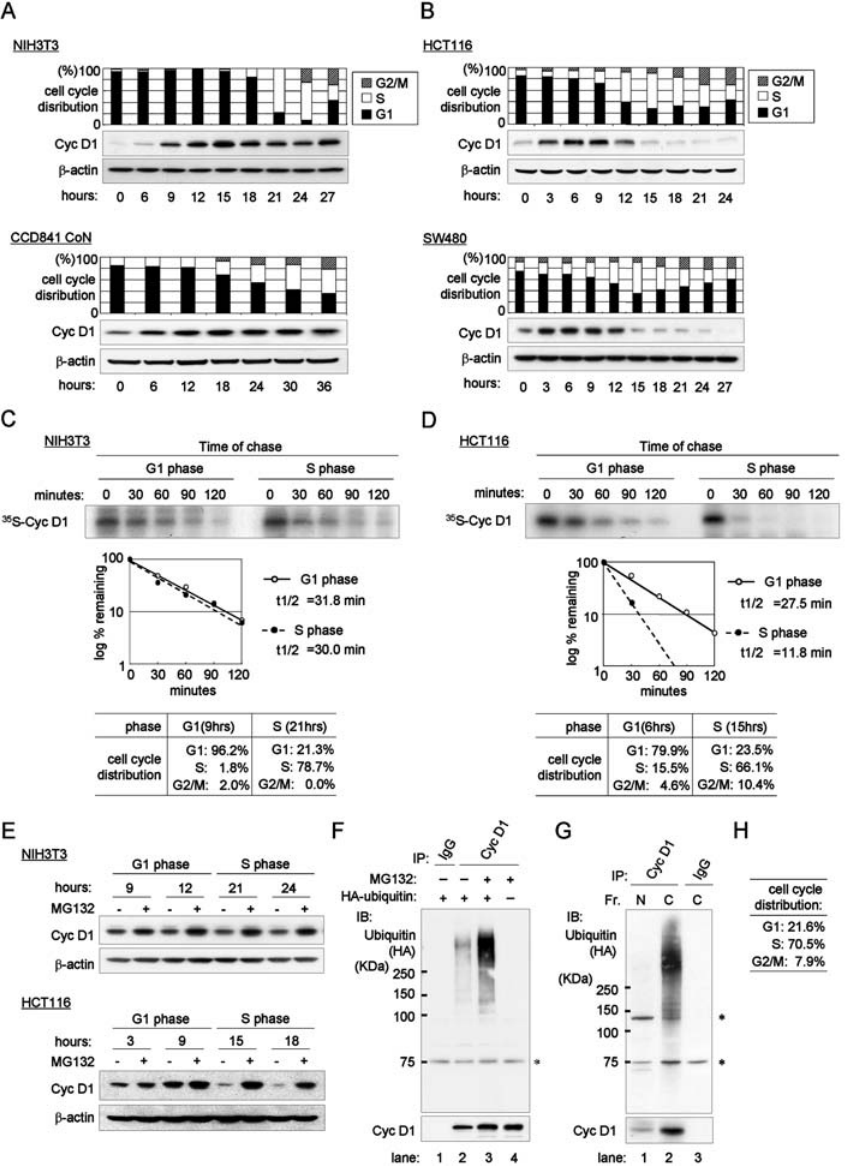
Figure 1. Cyclin D1 is destabilized during S phase through the ubiquitin-proteasome pathway in cancer cells. (A, B) Expression profile of cyclin D1 during cell cycle progression in cells released from quiescence. Normal cells (A) and cancer cells (B) were tested. (A) NIH 3T3 mouse fibroblasts and CCD841 CoN normal colon epithelium. (B) HCT 116 and SW480 cells. CCD841 CoN cells were synchronized at G0/ G1 phase by treatment with ACL-4 media without EGF for 24 hrs, and then stimulated with complete ACL-4 media containing EGF. Other cells were released from quiescence by serum stimulation. Samples were collected at indicated time points. Cell cycle distributions were determined by flow- cytometry and percentages of each phase are indicated. Western-blots were performed with cyclin D1 and b -actin antibodies, respectively. (C, D) Pulse-chase analysis of cyclin D1 in NIH 3T3 cells (C) and HCT 116 cells (D). Cells were released from quiescence and labeled with 35 S-methionine for 1 hour when most of the populations were in G1 phase (9 hrs for NIH3T3 and 6 hrs for HCT 116) or in S phase (21 hrs for NIH3T3 and 15 hrs for HCT 116). The cells were chased with cold methionine for the indicated times and then lysed. Cyclin D1 was immunoprecipitated and analyzed with SDS-PAGE. Autoradiography was performed. Levels of metabolically labeled-cyclin D1 were estimated by quantitative scanning using Quantity One software (Bio-Rad) and blotted on the graph to determine the half-life of cyclin D1. Cell cycle distribution is indicated below the figures. (E) Turnover of cyclin D1 is mediated by the ubiquitin-proteasome pathway. NIH3T3 and HCT 116 cells were released from quiescence by serum stimulation and treated in the presence ( + ) or absence ( 2 ) of MG132 for 2 hrs prior to harvesting at each time point. Western blot was performed with cyclin D1 and b -actin antibodies. (F–H) Polyubiquitination of cyclin D1. (F) HCT 116 colon cancer cells were transfected with HA-tagged ubiquitin cDNA (lanes 1–3) or without it (lane 4) and then synchronized to S phase through the sequential manipulation of serum starvation and stimulation. Cells were treated with 25 m M MG132 (lanes 3 and 4) or without it (lanes 1 and 2) for one hour. Lysates were immunoprecipitated with antibodies to cyclin D1 antibody (lanes 2–4) or control IgG (lane 1) and immunoblotted with a HA antibody (upper panel) or a cyclin D1 antibody (lower panel). Asterisks indicate background non- specific bands (F–G). (G) Nuclear (N) and cytoplasmic (C) proteins were fractionated (Fr.) from cell lysates collected in Panel F, lane 3. Nuclear and cytoplasmic extracts were immunoprecipitated with antibodies to cyclin D1 (lanes 1 and 2) or IgG (lane 3) and immunoblotted with a HA antibody (upper panel) or a cyclin D1 antibody (lower panel). (H) Cell cycle distributions. doi:10.1371/journal.pone.0000128.g001 PLoS ONE |